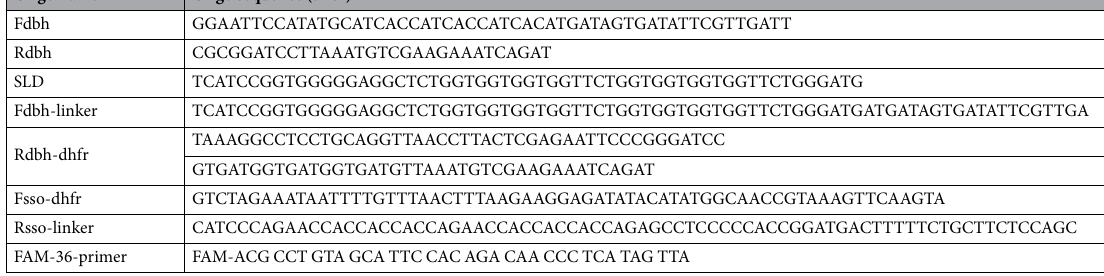
Table 4. Oligonucleotides used in this